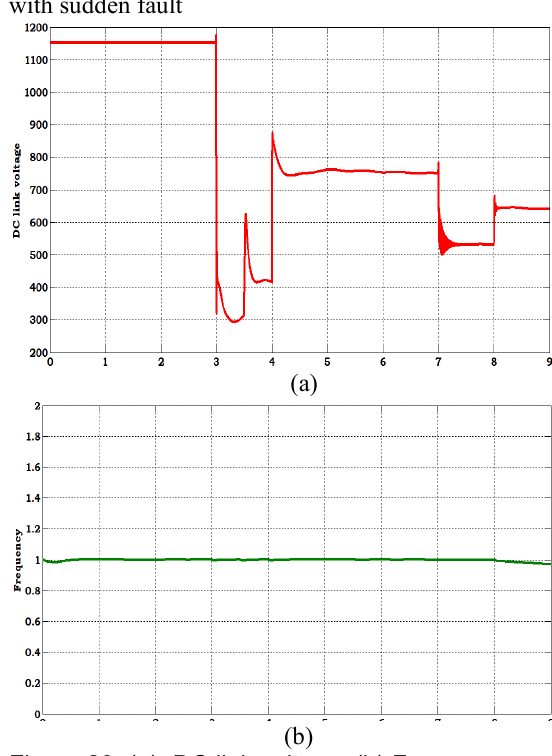
Figure 29. (a). DC link voltage, (b).Frequency